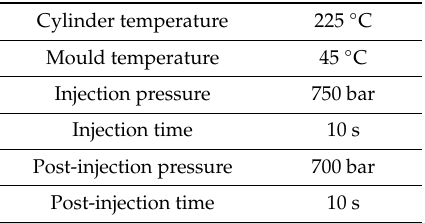
Table 5. Injection process